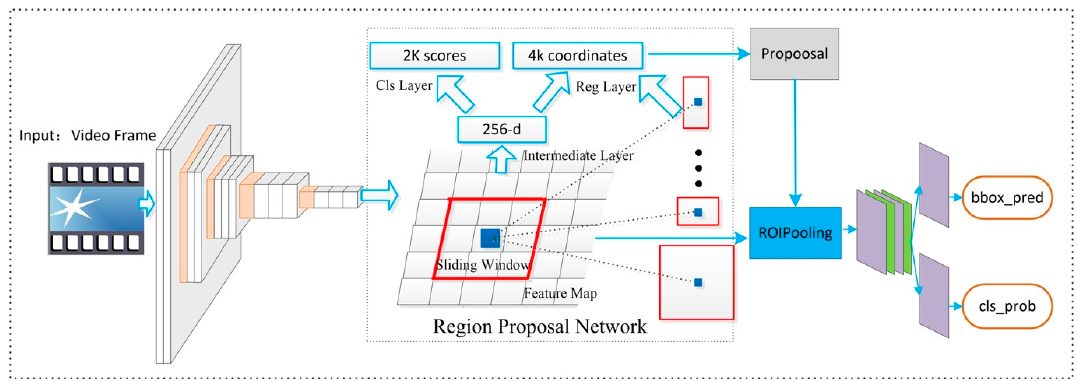
Figure 2. Our network of multi-object detection, include VGG16 and region proposal network.